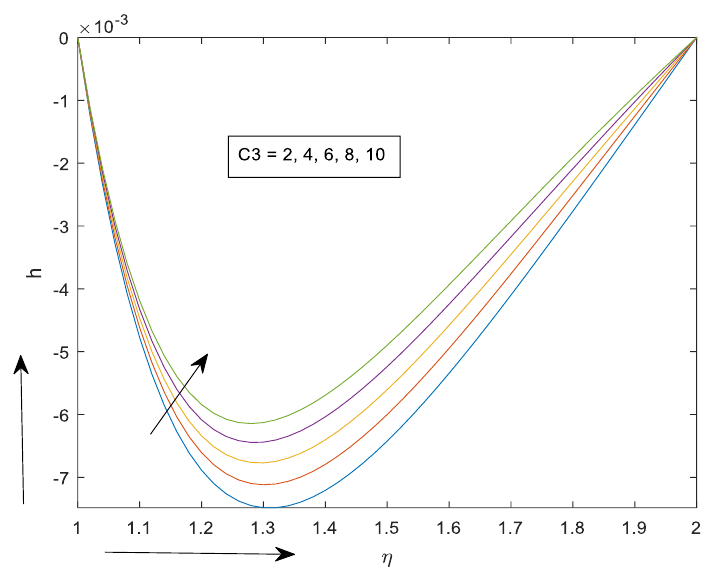
Figure 10. Angular velocity profile for different values of 𝐶